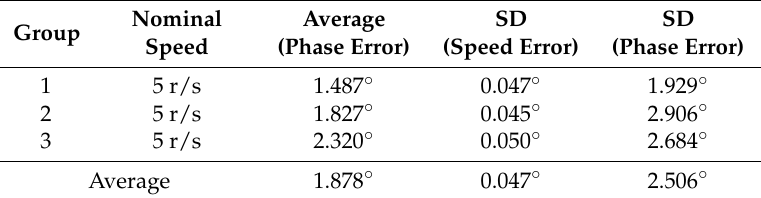
Figure 23. Results of group 3: ( a ) Description of digital amplitude of B Z ; ( b ) Comparison of pulses produced by hall sensor and controller; ( d ) Description of speed figured out from controller; ( e ) Description of speed error and phase error. Table 5. Results of experiments.